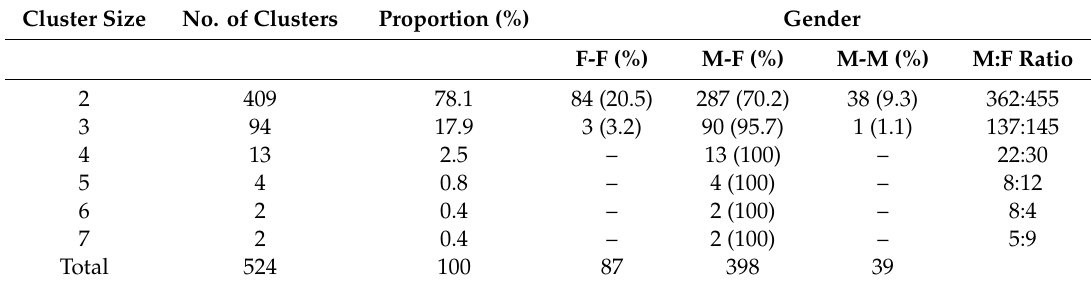
Table 3. Cluster size distribution.